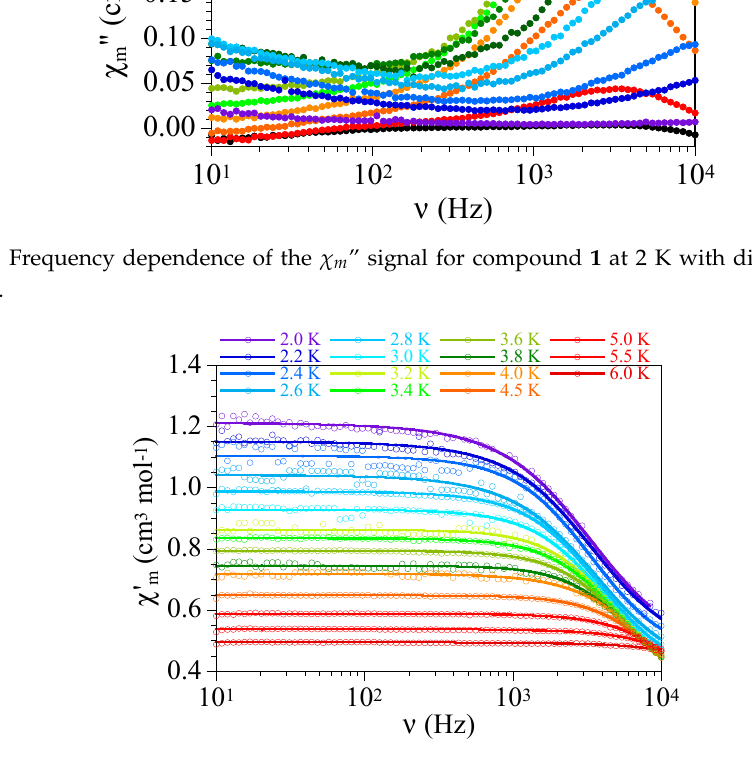
Figure 7. Frequency dependence of the out-of-phase AC susceptibility for 1 with an applied DC field of 800 Oe at different temperatures. Solid line is the best fit to the Debye model (Equation (3)). The frequency-dependence of the in-phase ( χ m ′ ) and out of phase ( χ m ′′ ) signals for a DC field of 800 G has been fit with the Debye model using the following equations [42]: 𝜒 (cid:4593) (𝜔) = 𝜒 (cid:3020) + (𝜒 (cid:3021) − 𝜒 (cid:3020) )[1 + (𝜔𝜏) (cid:2869)(cid:2879)(cid:3080) 𝑠𝑒𝑛 1 2(cid:3415) 𝛼𝜋] 1 + 2(𝜔𝜏) (cid:2869)(cid:2879)(cid:3080) 𝑠𝑒𝑛 1 2(cid:3415) 𝛼𝜋 + (𝜔𝜏) (cid:2870)((cid:2869)(cid:2879)(cid:3080))